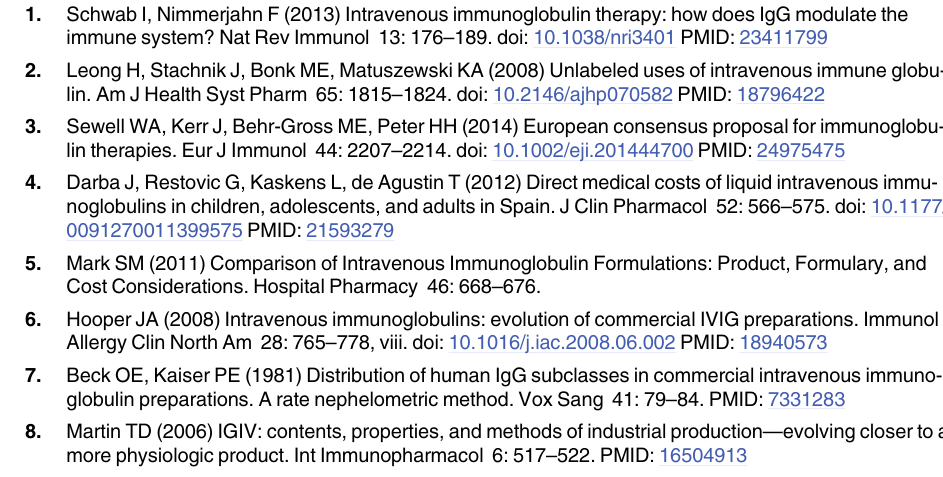
S2 Fig. Differences between IVIg preparations. S1 Table. Differences between IVIg preparations. S2 Table. IVIg lot-numbers. S3 Table. Overview of all glycoforms for the tested IVIg